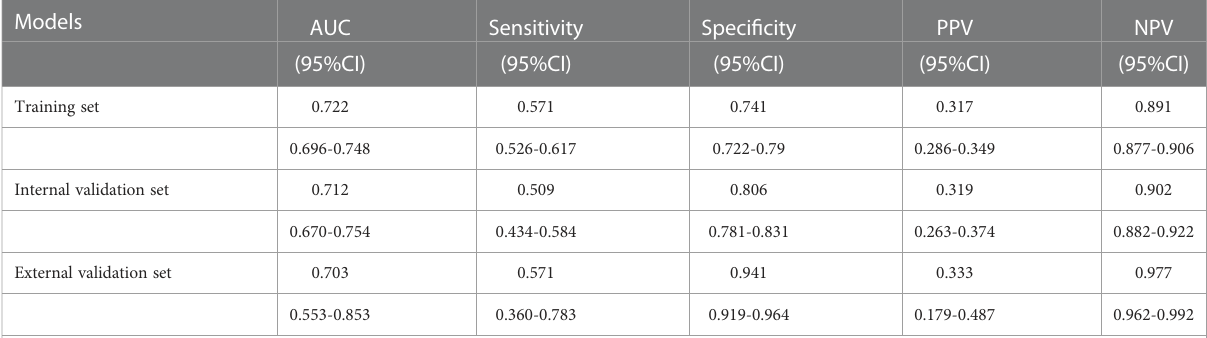
TABLE 4 Detailed performance metrics for the three